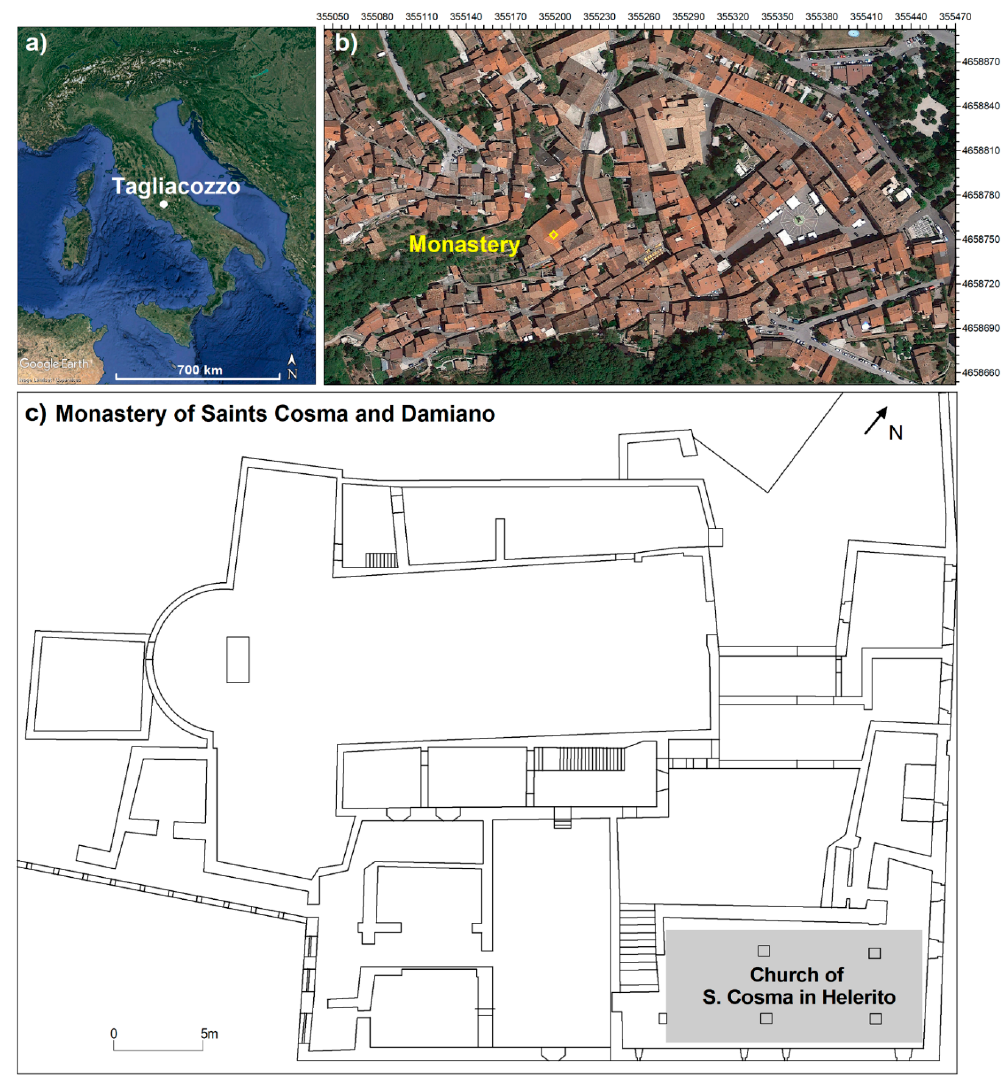
Figure 1. Location of Tagliacozzo (L’Aquila, Italy) ( a ) and the Monastery of Saints Cosma and Damiano ( b ) on a Google Earth TM satellite image and an indication of the Church of Saint Cosma in Helerito inside the planimetry of the monastery ( c ).